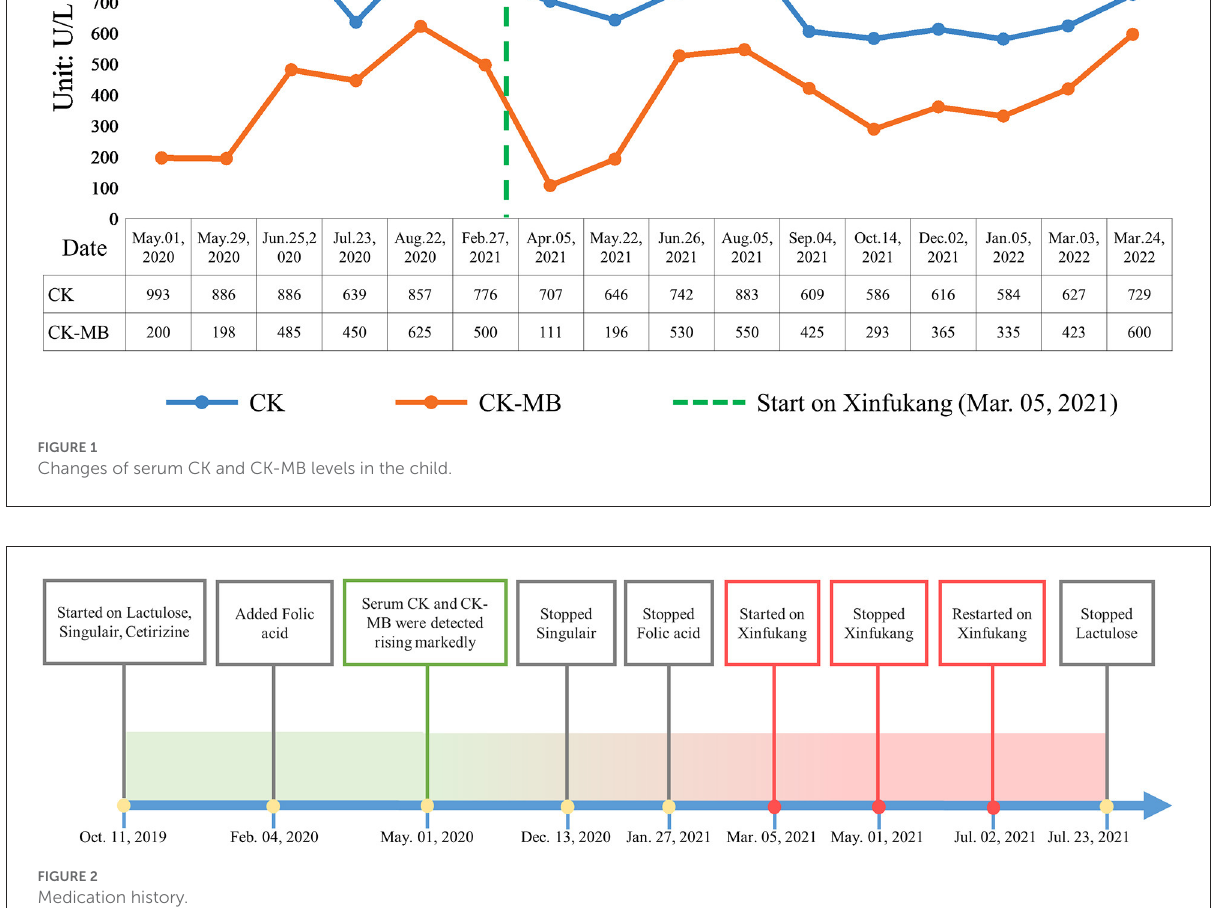
FIGURE2 Medication